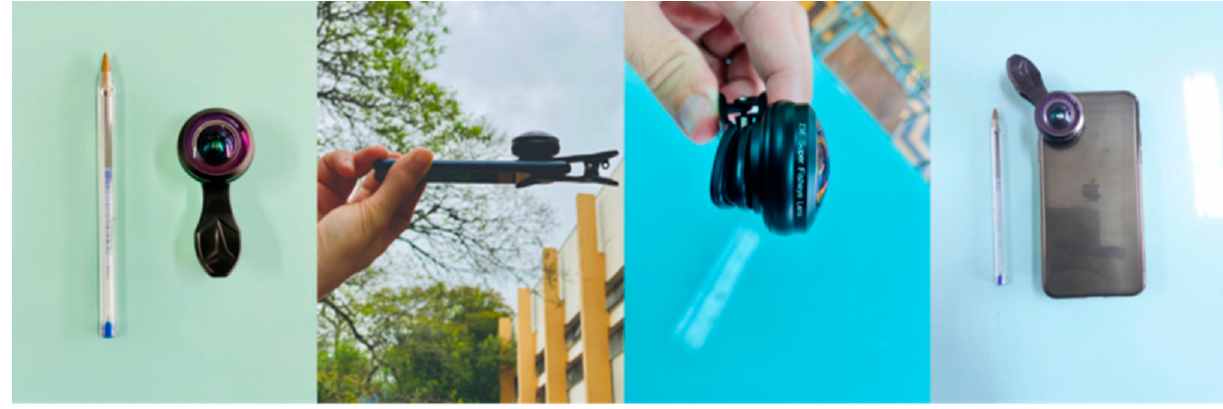
Figure 6. SVF of the urban climate data collection points in Balneário Camboriú. Source: The au- thors (2022). 2.3. Data Processing and Analysis In RayMan Pro, the processing and calculation of the SVF of the photos was per- formed. This program is freely available and is continuously updated and enhanced. It was created for urban climate research with an emphasis on applied climatology [24]. The software’s primary simulation inputs are Ta, relative humidity (RH), and wind speed (Ws). In order to estimate the impact of morphological changes, the calculations were based on photos captured with a fisheye lens (Figure 5) and the sun’s path. Thus, the method enables examination of the area’s many layouts, such as the edge, proximity to green spaces, and urban canyons [24]. This research also makes use of the Balneário Camboriú LCZs, which were designed first. This technique has been utilised in a number of global research studies, as well as